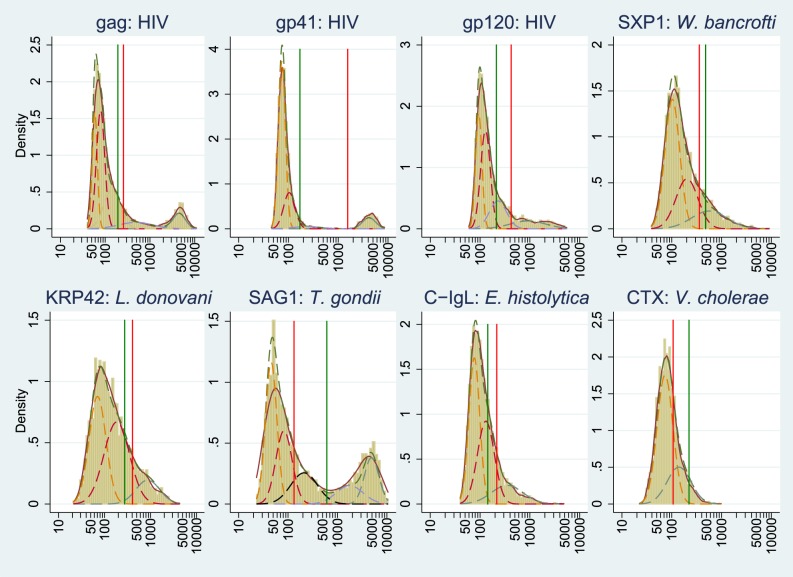
Distribution of median fluorescence intensity (MFI) for antigens of HIV (gag, gp41, and gp120), W. bancrofti (SXP1), L. donovani (KRP42), T. gondii (SAG1), E. histolytica (C-IgL), and V. cholerae (CTX).Solid lines: Kernel density of the distribution. Actual distributions are expressed as histograms. Dotted lines: Normal distribution separated by mathematical models (finite mixture models) used to calculate cut-off values for each antigen. Vertical lines: Green represents cut-off values calculated using Japanese volunteers; red represents those calculated by two normal distributions obtained by mathematical models. MFI: outcome value of the microsphere-based assay system; these values are roughly equivalent to antibody titer.